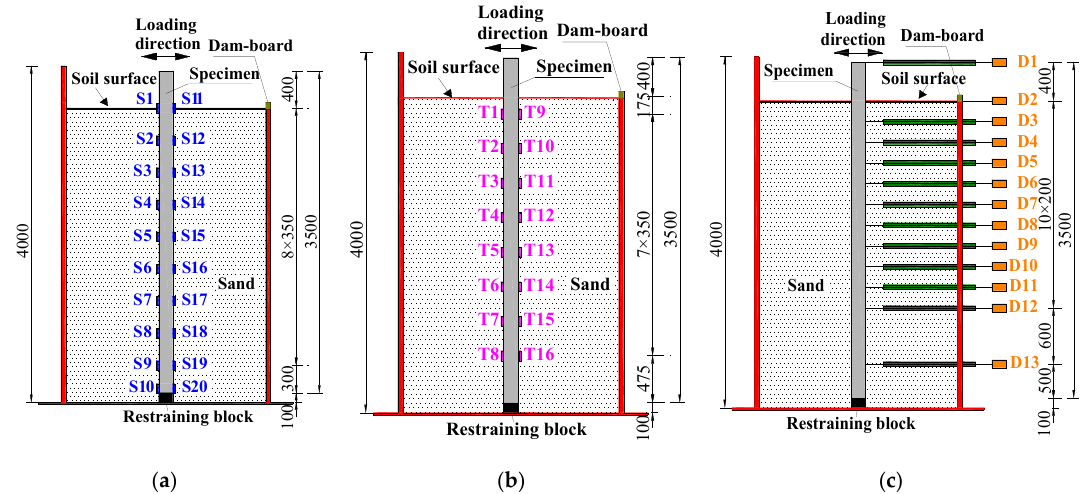
Figure 5. Sensor layouts of specimens (unit: mm). ( a ) Strain gauges details. ( b ) Soil pressure cells details. ( c ) linear variable displacement transducers (LVDTs) details.